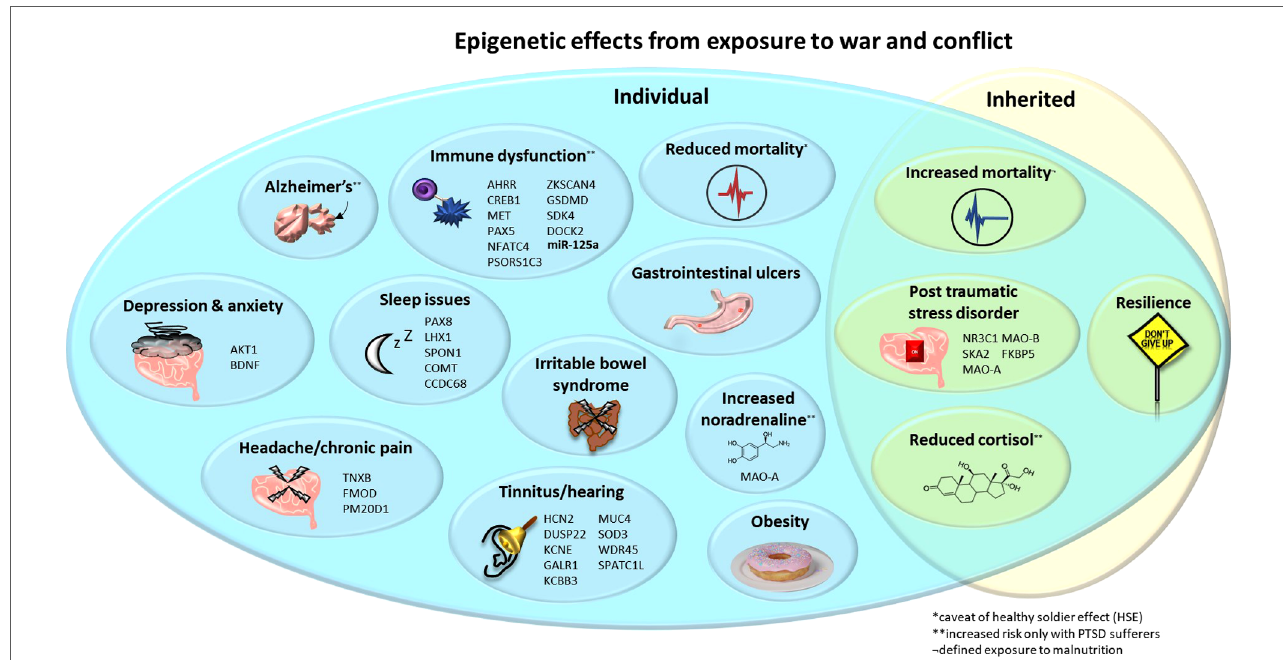
FIGURE 1 Epigenetic effects from exposure to war and con fl ict. Upon the individual: decreased cortisol, mortality* and sleep quality/quantity; increased mortality, PTSD, noradrenaline**, tinnitus, immune dysfunction, Alzheimer ’ s disease**, obesity, anxiety, depression, gastrointestinal ulcers and IBS in children exposed to war. Inherited: decreased cortisol and mortality*, and increased risk of PTSD but also resilience. Noted are genes (and the microRNA miR-125a where expression is altered) that are associated with these pathologies and may occur differentially methylated and/or expressed. *Decreased mortality, potentially as a confounding “ healthy solider effect ” . **Increased risk only in individuals with PTSD. IBS, irritable bowel syndrome; PTSD, post-traumatic stress